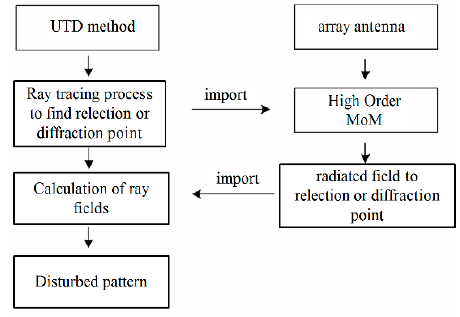
Figure 1. Brief procedure of quasihybrid scheme.